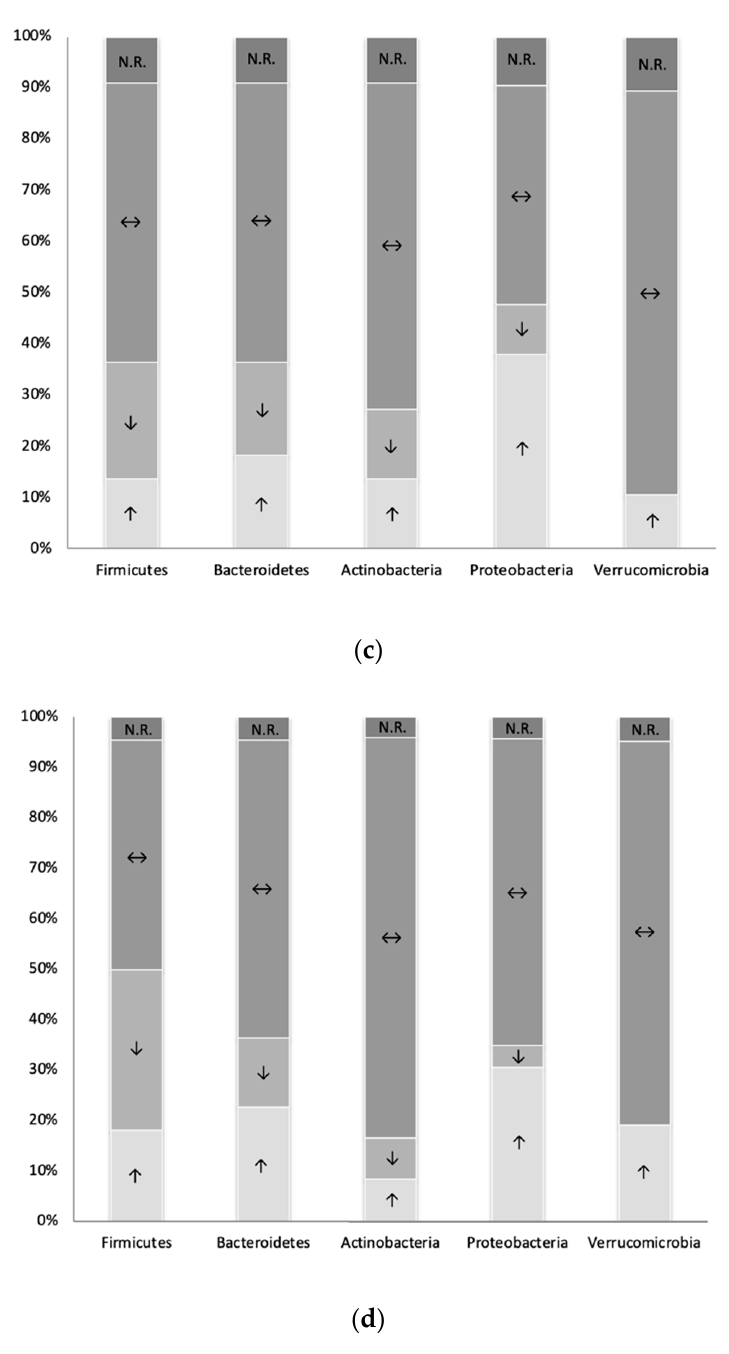
Figure 2. Microbiota changes in the context of bariatric surgery. ( a ) Subgroup 1 diversity changes; ( b ) Subgroup 2 diversity changes; ( c ) Subgroup 1 phylum changes; ( d ) Subgroup 2 phylum changes. ↑ : Increase / higher; ↓ : Decrease / lower; ↔ : Stable / nil difference; N.R.: Not reported.